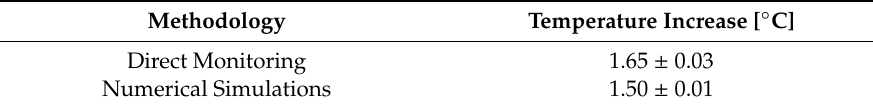
Table 3. Temperature increase at the monitoring hole ( MH ) location.